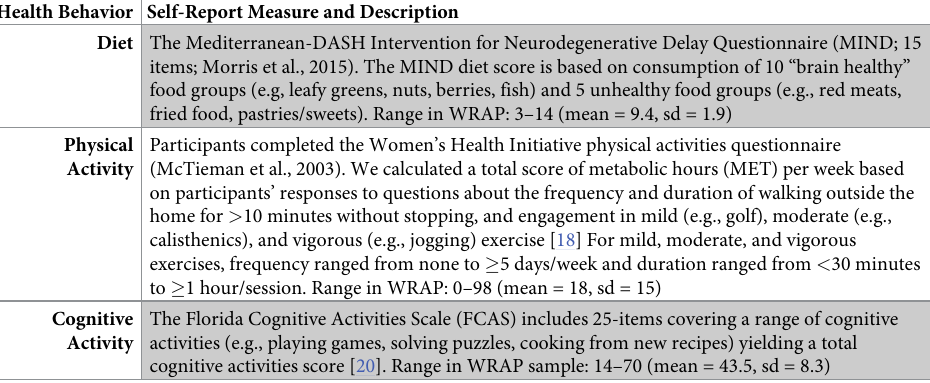
Table 1. Description of self-reported health